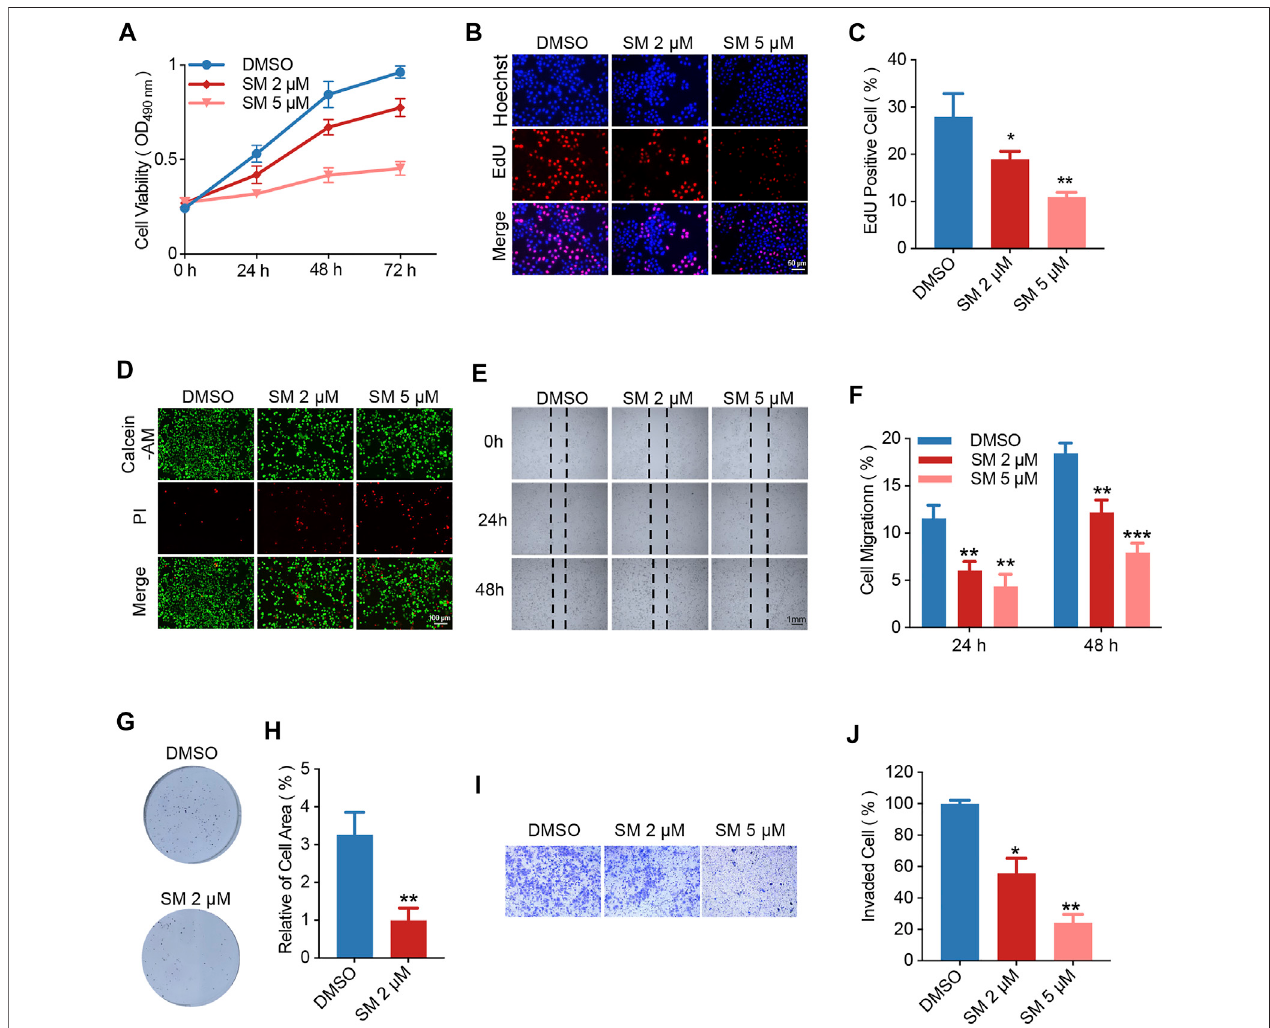
FIGURE 1 | SM Inhibits FaDU cell proliferative and migration ability. (A) Cell viability of FaDU cells treated with DMSO and 2 and 5 μ M SM was analyzed by MTT assay at 0, 24, 48, and 72 h ( n = 5). (B,C) EdU/Hoechst staining of FaDU cells treated with SM (2 and 5 μ M) for 48 h. The ratio of EdU + cells calculated using ImageJ software was used to characterize cell proliferation ( n = 3). (D) Calcein AM/PI staining of FaDU cells treated with SM (2 and 5 μ M) for 48 h. (E,F) Cell migration of FaDU cellswastested bywoundhealingassayaftertreatmentwithDMSOand2and 5 μ MSM,andtheratiowascalculatedbyImageJsoftware. (G,H) Colonyformation of FaDU cells was performed with DMSO and 2 and 5 μ M SM. Relative of cell area statistic with ImageJ software. (I,J) Cell invasion was analyzed using the transwell assay ofFaDU cells treated with DMSO and 2and 5 μ M SM. The relative migration rate wascalculated with ImageJ software. *( p < 0.05), **( p < 0.01), and ***( p < 0.001) indicate statistically signi fi cant